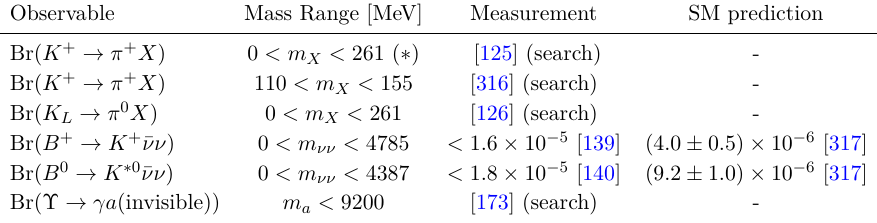
Table 3 . Observables relevant for a long lived ALP. Bounds are at 90% CL. ( ∗ ) : cuts are applied to exclude the region around m